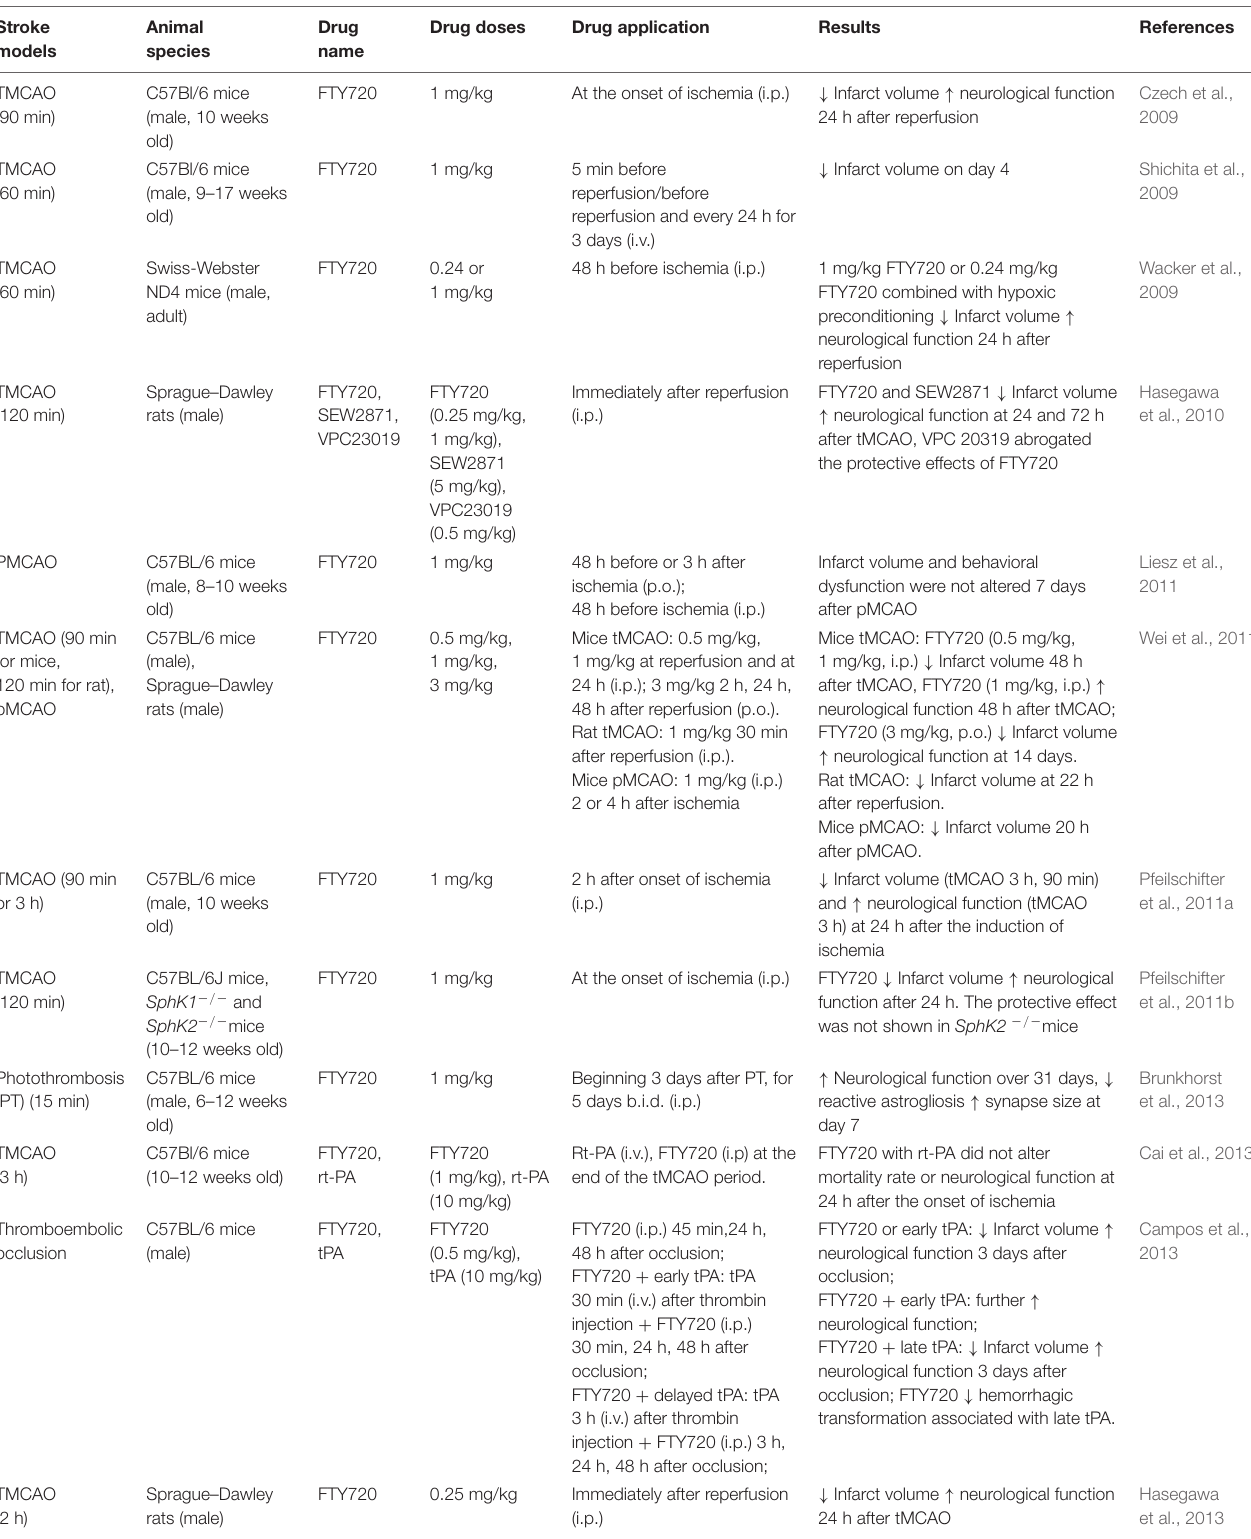
TABLE 1 | Animal studies of S1P modulators in ischemic stroke.